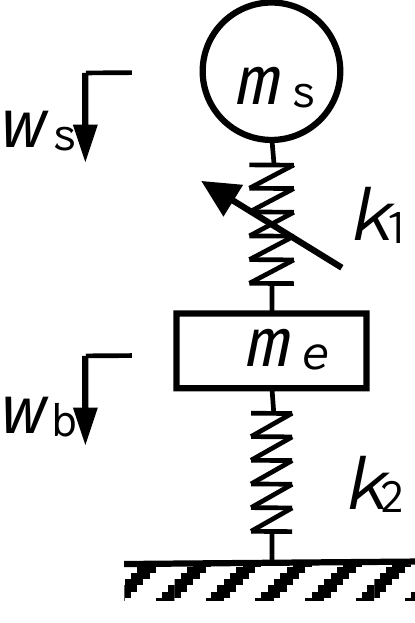
Figure 5. Two degree-of-freedom spring-mass model.